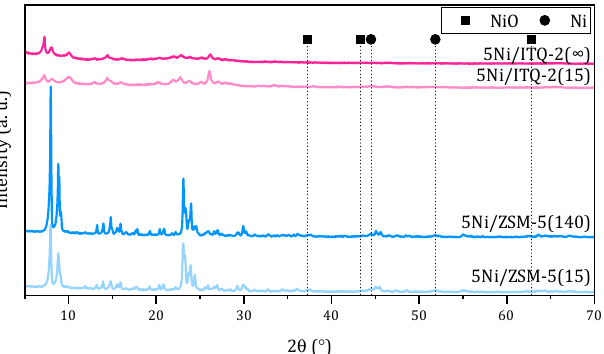
Figure 5. XRD patterns of the 5 wt.% Ni catalysts supported on ITQ-2 and ZSM-5 with different Si/Al ratios after the reaction test.